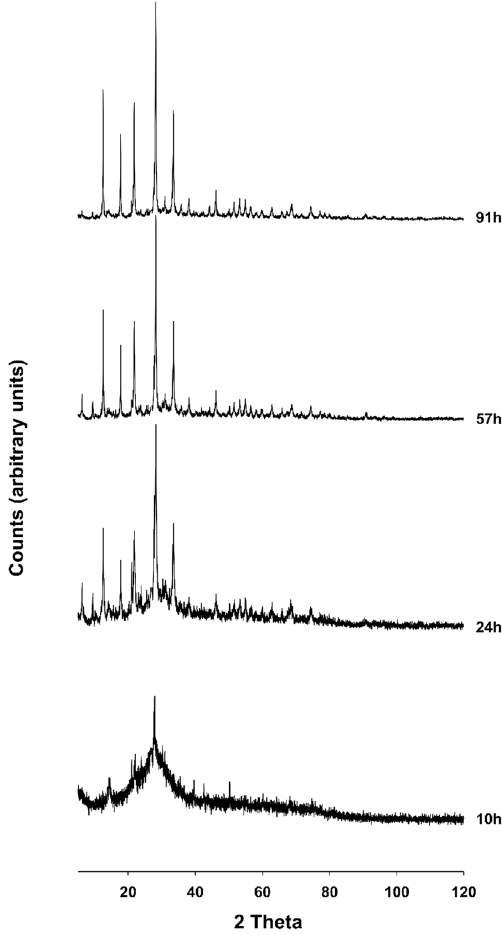
Figure 1. X-ray diffractometric sequence of the synthesis run at 65